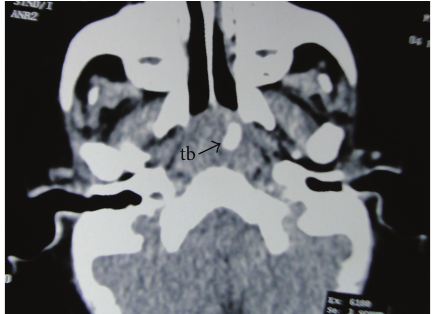
Figure 2: CT scan passing through the external auditory meatus, showing the handle of the toothbrush (tb) in the retropharyngeal space of the nasopharynx.